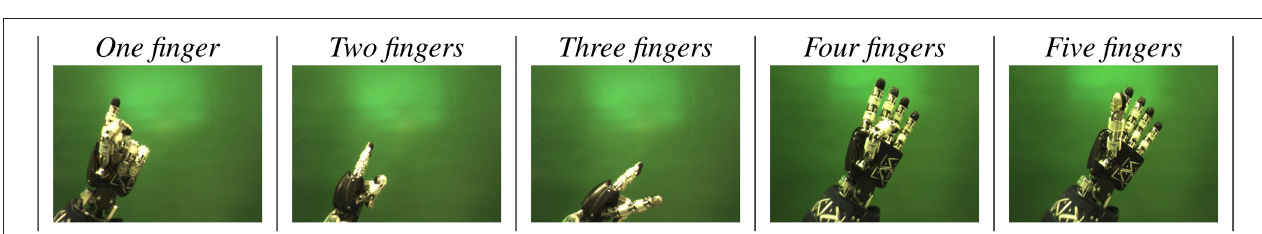
FIGURE 6 | Pictures showing examples of hand positions that are difficult for networks to classify unambiguously. The “one finger” image is classified by FRCNN3 as having four fingers on display because of the palm position. The “two fingers” and “three fingers” images provide an example of overlap, hard to identify the correct number also for the human eye. The “four fingers” and “five fingers” images show subtle variation in the hand position that may easily confuse the